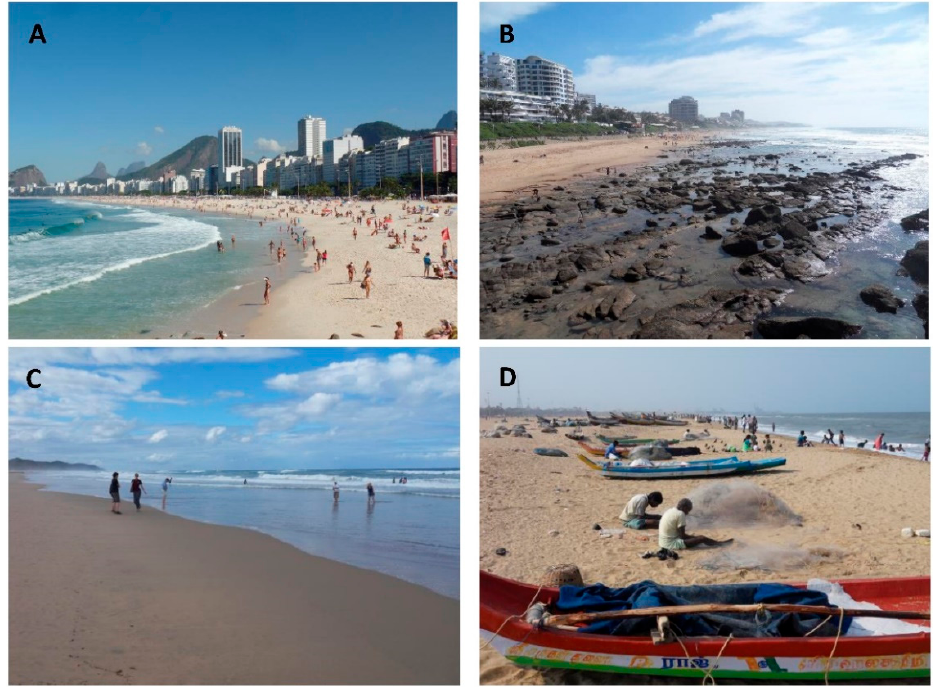
Figure 4. Examples of people–beach interactions and different types of activities supported in beach spaces. ( A ) Rio de Janeiro, Brazil; ( B ) Durban, South Africa; ( C ) St Lucia, South Africa; ( D ) Chennai, India (photos: author).